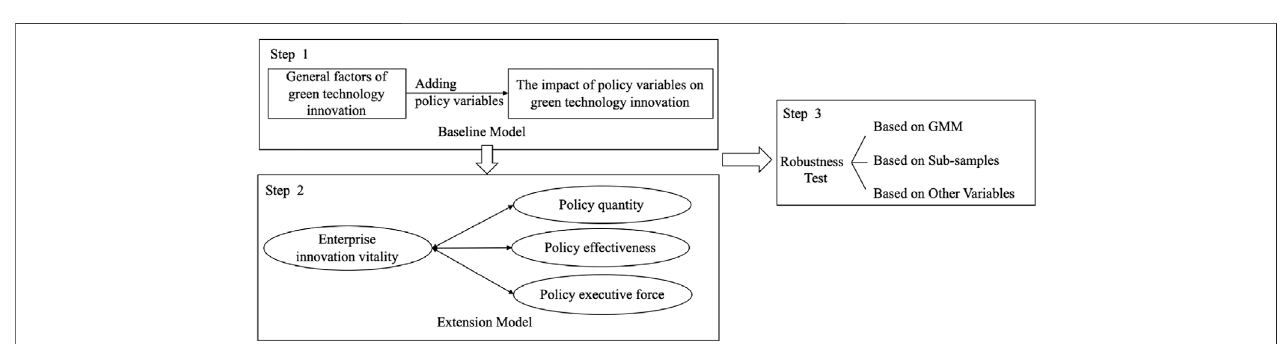
FIGURE 2 | Flowchart of research